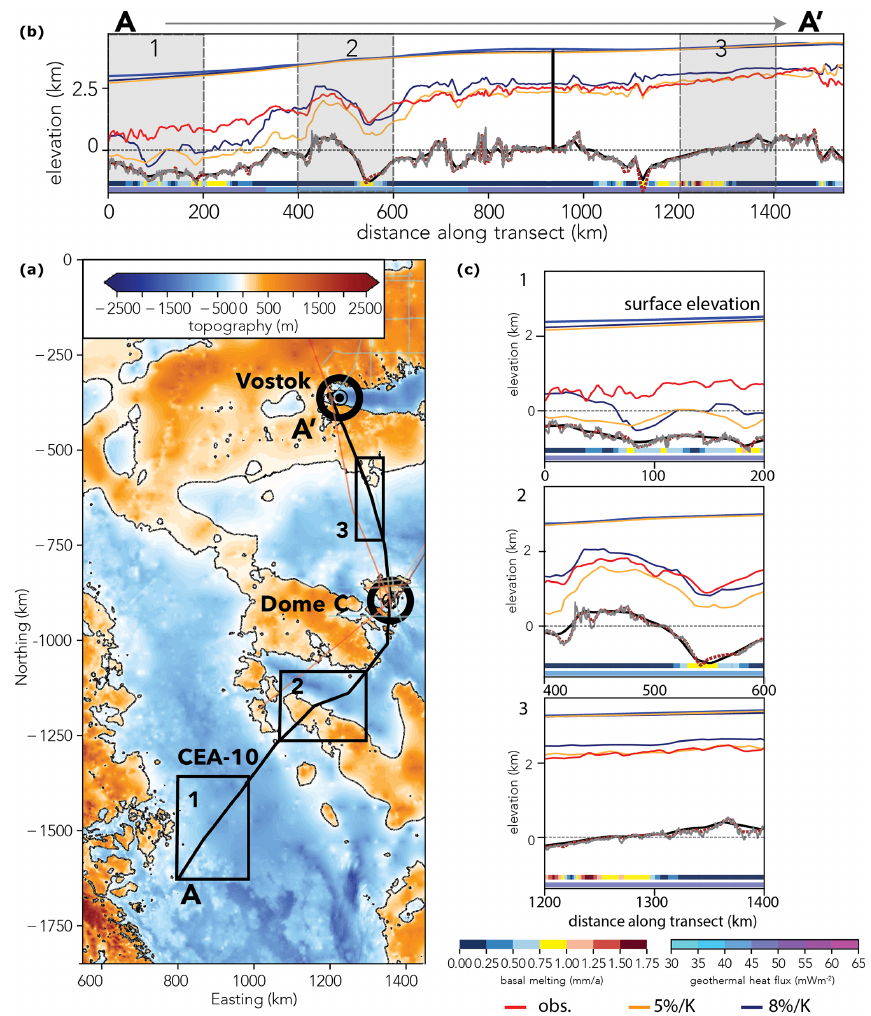
Figure 10. Overview of transect CEA-10. Panel (a) shows the bedrock elevation from Morlighem et al. (2020) at 1km resolution overlain by the CEA-10 transect in black and other radar transects analysed in this study (thin coloured lines). Panels (b) and (c) illustrate the ice surface (observed: dark blue; modelled: blue (8%K − 1 ), yellow (5%K − 1 )), bedrock and isochrone elevation of the 90ka radar reflector (modelled: blue (8%K − 1 ), yellow (5%K − 1 ); observed: red) along transect CEA-10 (the position of the EDC ice core is illustrated by the vertical black line in panel b ). Bedrock elevation in the pal model run is plotted in black and the BedMachine Antarctica 1km grid resolution bedrock in red. Shaded areas in (b) are shown additionally in a detailed view (c) . Sea level (zero-elevation) is depicted by the dotted black line. The coloured bars on the bottom of (b) and (c) depict the geothermal heat flux (Shapiro and Ritzwoller, 2004) and the computed basal melt rate along the